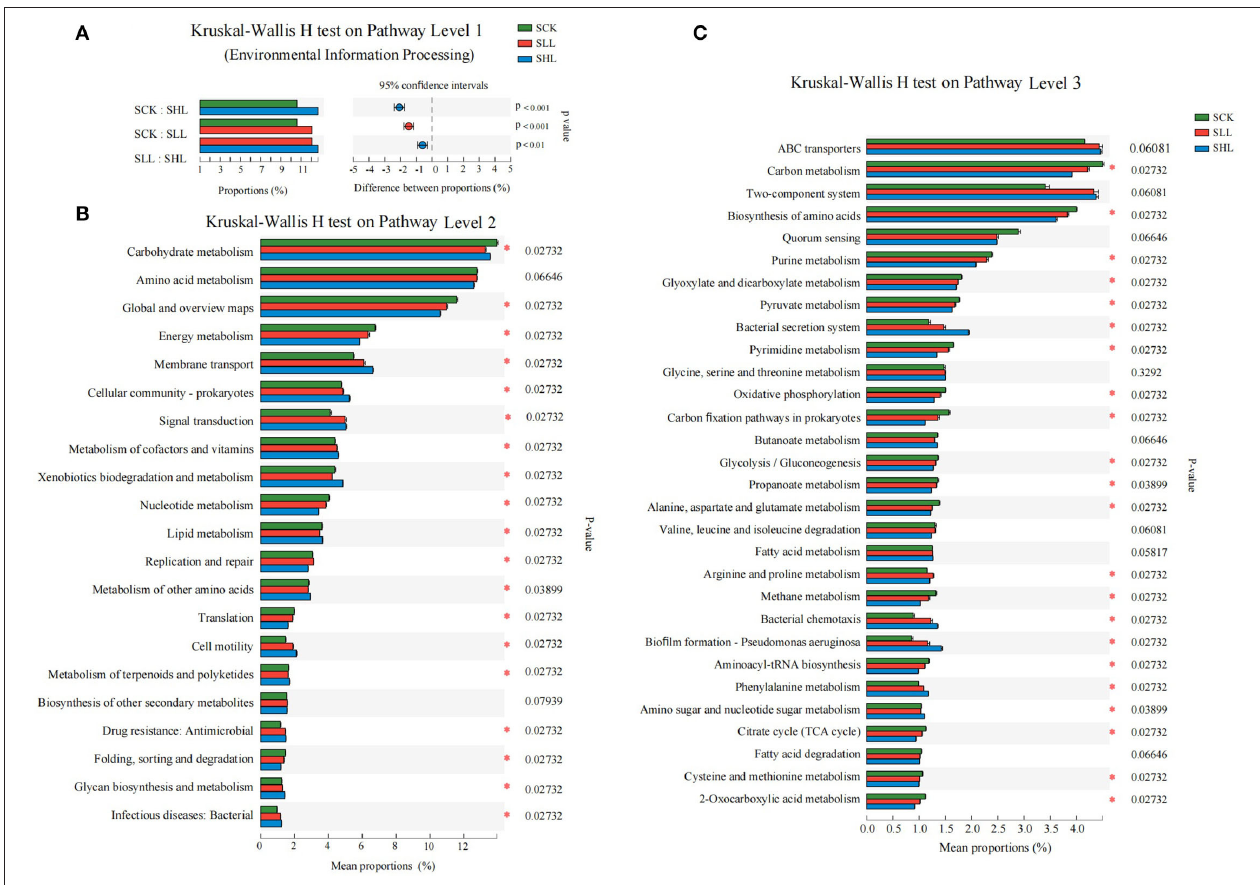
FIGURE 5 | Relative abundance of predicted genes related to KEGG pathways at levels 1 (A) , 2 (B) , and 3 (C) showed significant differences among HLB-infected citrus rhizoplane soil samples. SCK, soil without lime treatment; SLL, soil treated with low-level lime; SHL, treated with high-level lime. Differences were considered significant at p < 0.05 by the Kruskal Wallis H